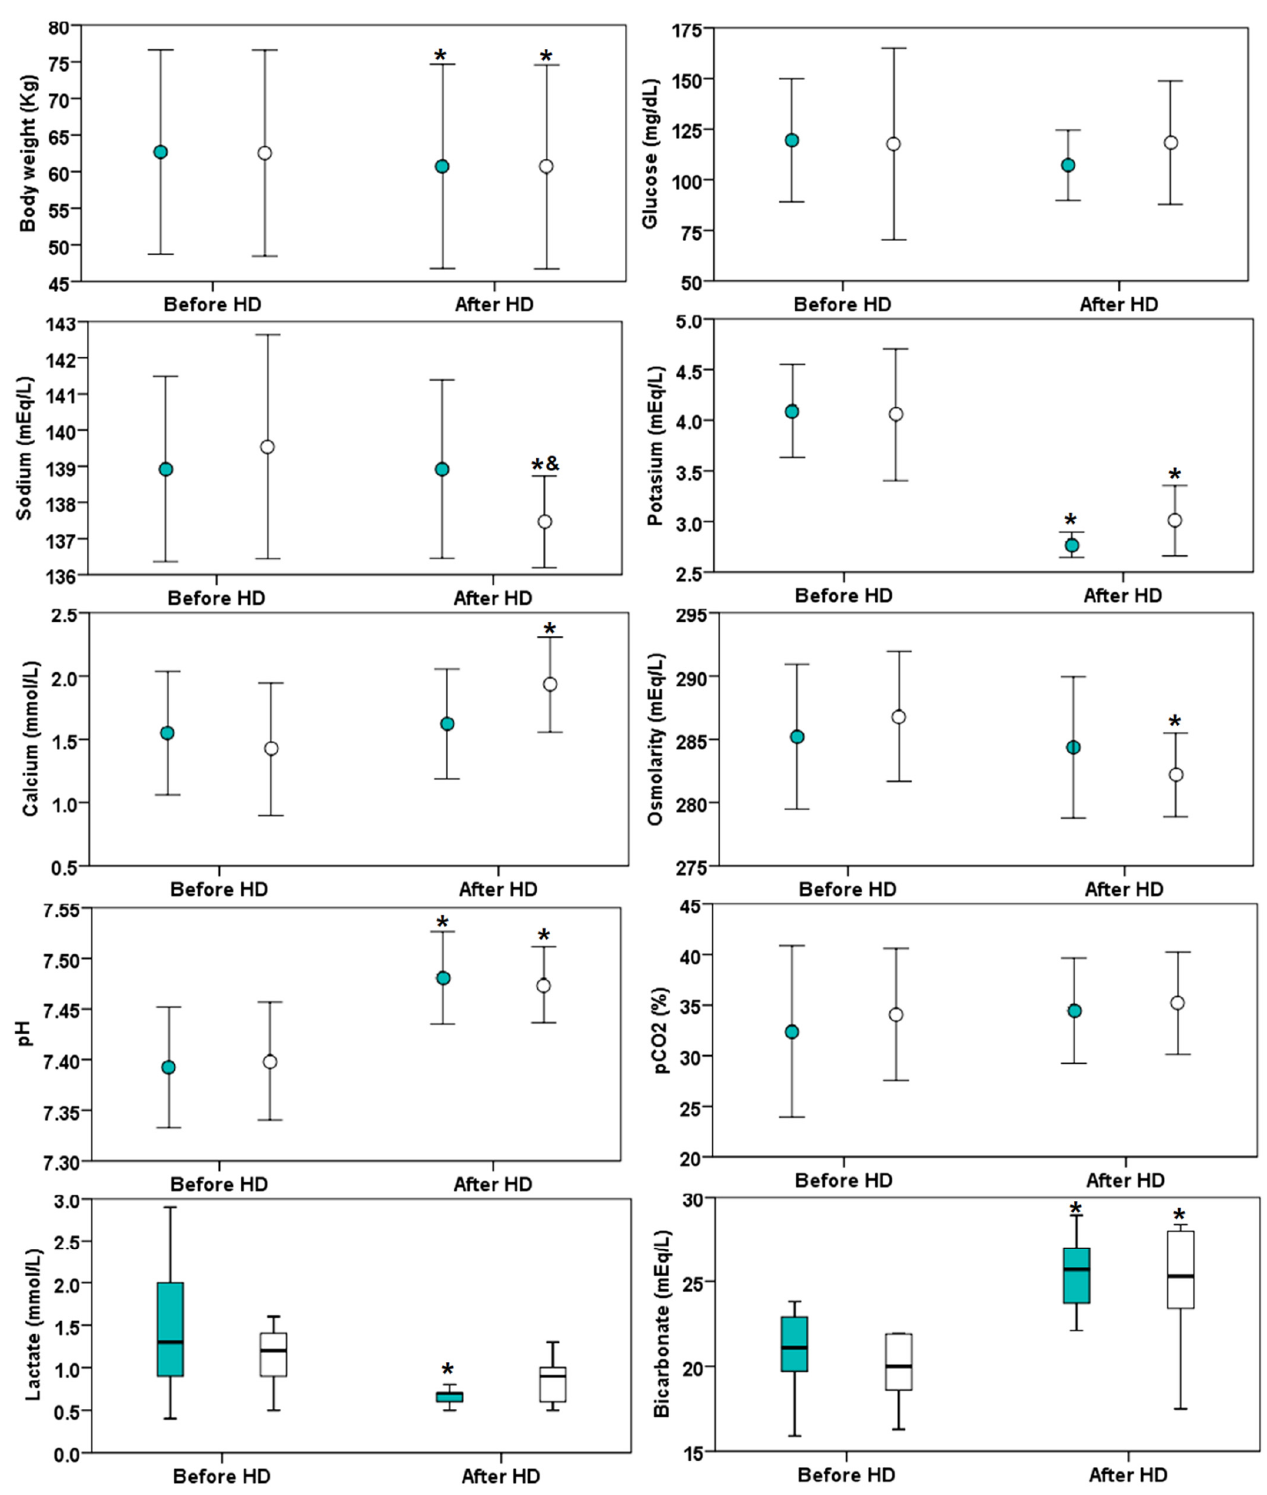
Figure 1. Biochemical parameters before and after hemodiafiltration (HDF) in 13 patients with different dialysate sodium profile: individualized indicated (green color markers) or fixed at 138 mmol/L (white markers). The asterisk (*) indicates p < 0.05 versus before HDF and the symbol & indicates p < 0.05 versus fixed sodium. The circle markers indicate mean values (± standard deviation) while the box plots indicate medians (horizontal line), interquartile range (box) and 1.5 time the interquartile range (error bars).